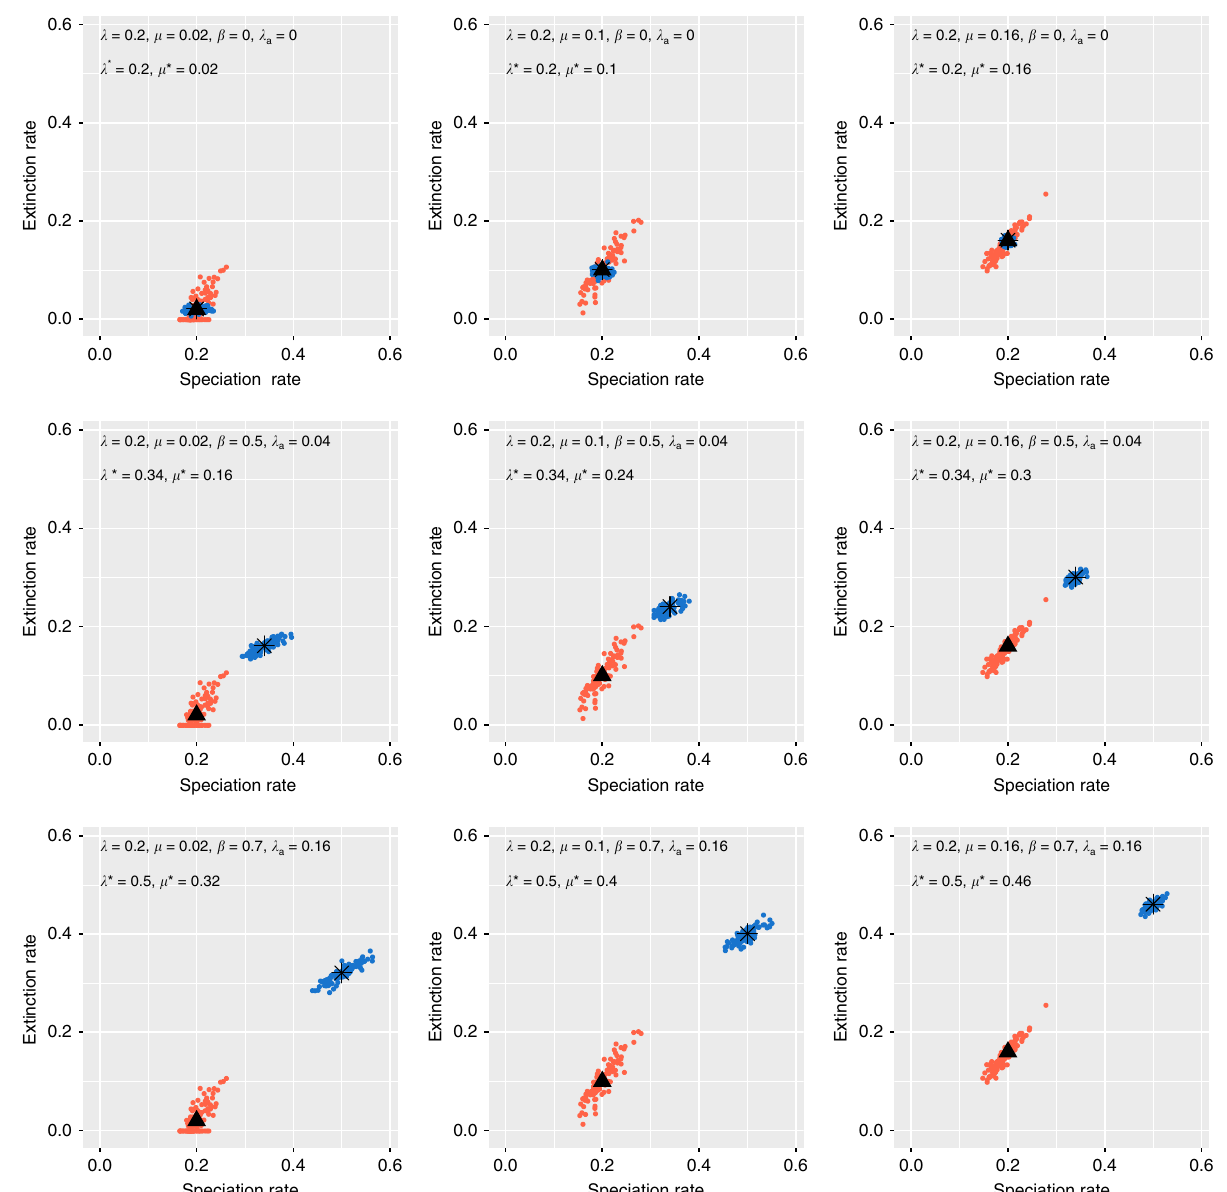
Fig. 2 Simulations of fossil and phylogenetic data under the BDC model. We simulated different proportions of cladogenesis via budding or bifurcation, anagenetic speciation, and extinction without replacement. Phylogenetic estimates of the speciation and extinction rates ( λ , μ ) are shown in red with black triangles representing the true values. The speciation and extinction rates ( λ *, μ *) estimated from fossil ranges are shown in blue with black stars representing the true